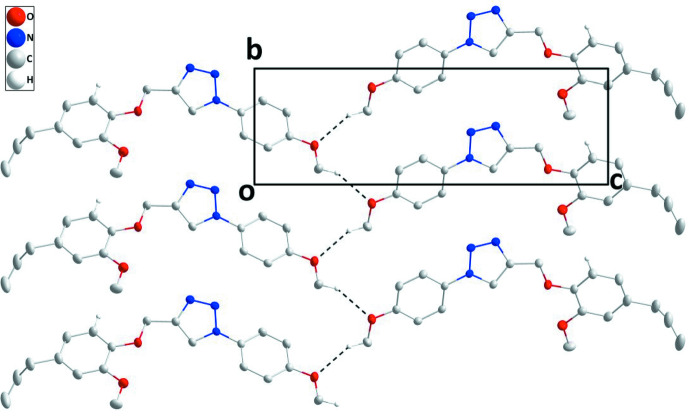
A portion of one layer viewed along the a axis, with C—HMthphn⋯OMthphn (Mthphn = meth­oxy­phen­yl) hydrogen bonds depicted by dashed lines.